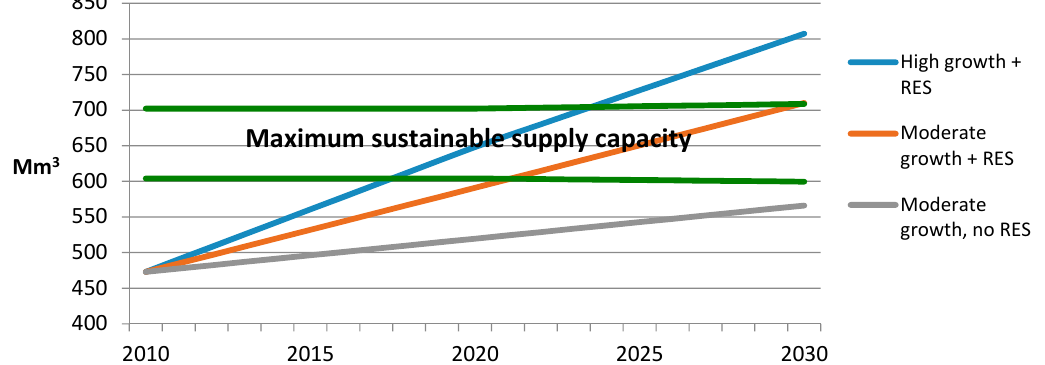
Figure 2. EU consumption scenarios compared to the EU forest sustainable supply capacity range, 2010–2030. Note: Consumption data are based on literature sources [18,39], noting that primary timber demand may be overestimated due to simplified assumptions. For indicative purposes, the sustainable supply range is extended back to 2010. This is based on a constant space for the period between 2010 and 2020 (e.g., ranging between around 600 and 700 Mm 3 ), which encompasses the realistic potential estimate using 80% of Net Annual Increment for 2010 determined in [31].